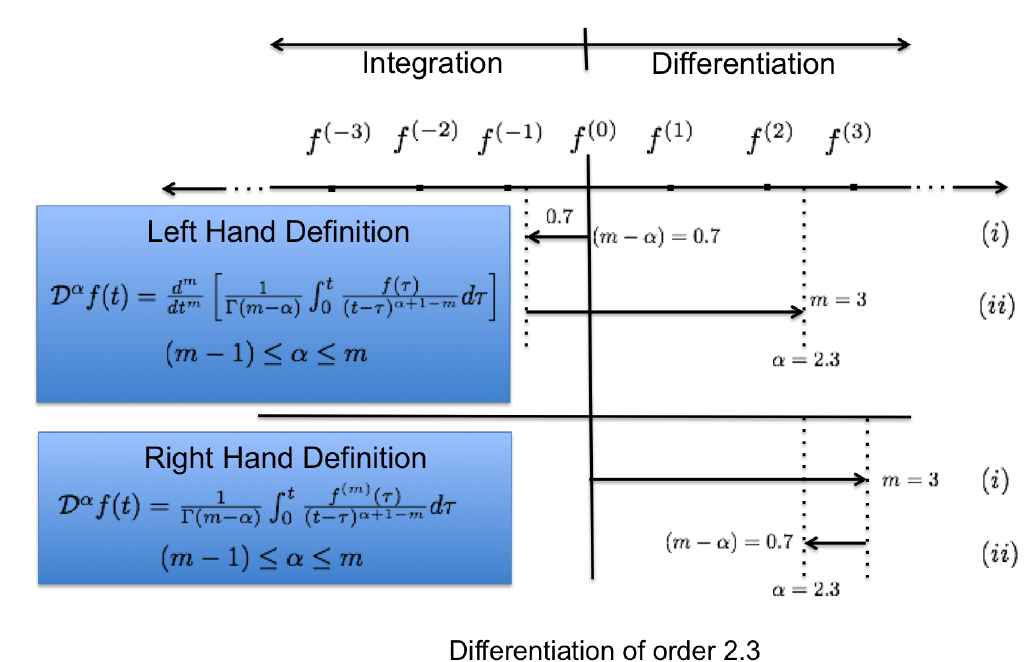
Figure 3. Fractional order calculus